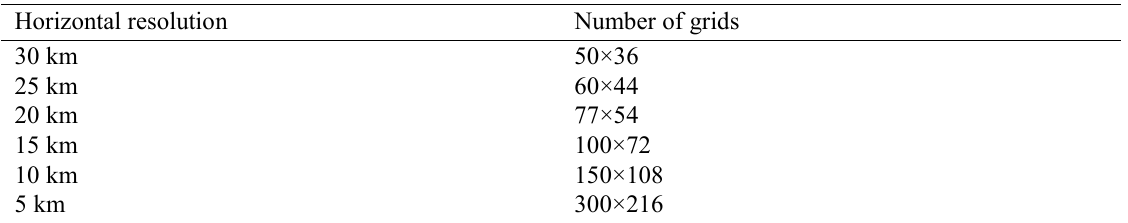
Table 2 The designations of simulations with different horizontal resolutions Horizontal